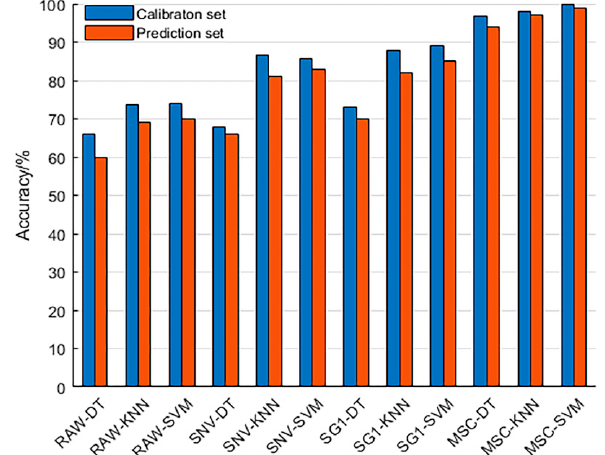
Figure 5. Modeling analysis results based on full wavelengths.